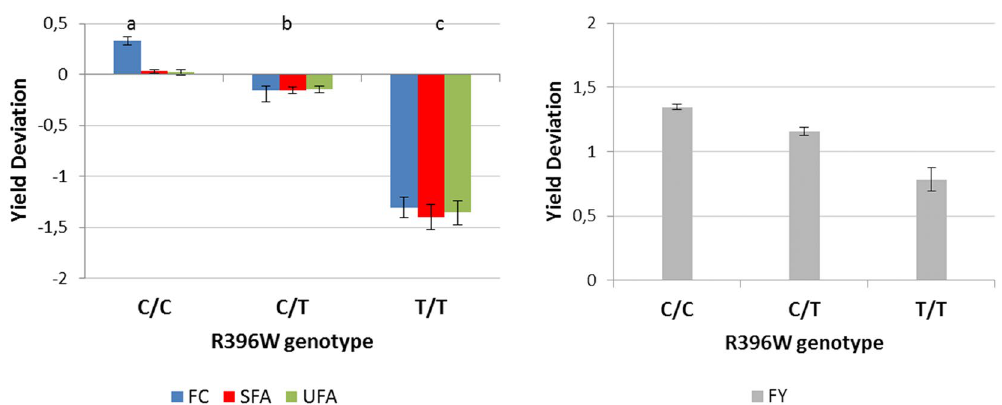
Figure 5. Effect of R396W genotype of DGAT1 gene on fat content (FC), quantity of saturated fatty acids (SFA) in milk, quantity of unsaturated fatty acids (UFA) in milk and fat yield (FY). The LS means have been estimated by using a mixed model including the genotype and the sire effect. Error bars indicate standard errors. Traits are expressed as the standard deviation of yield deviations. Lower case letters show significant differences in the trait between genotypes, as determined by a t-test at p < 0.05 for FY, and p < 0.005 for FC, SFA and